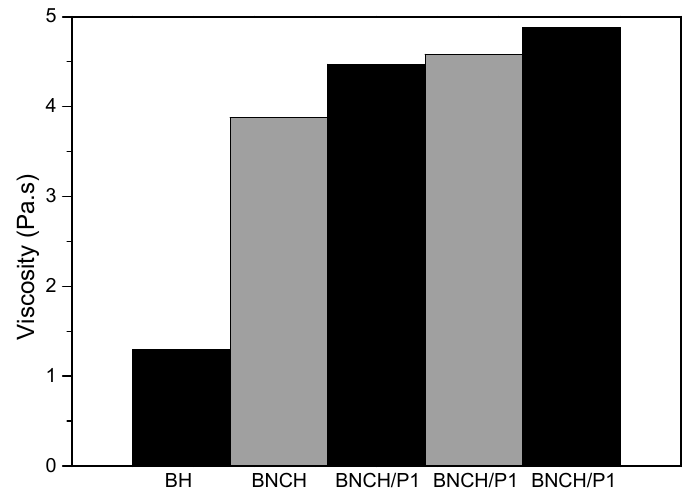
Figure 2. Viscosity of all BC-based hydrogel formulations. The viscosity is dependent on propolis content.